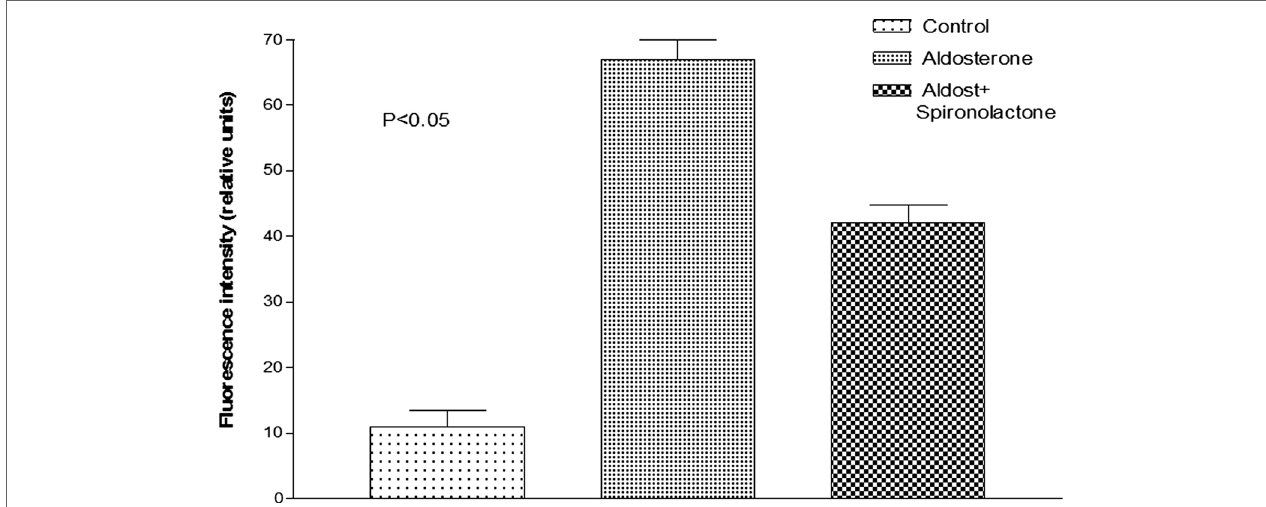
FigUre 6 | influence of aldosterone on oxidative stress . Each bar is the average from 23 ventricular myocytes (4 animals). Vertical line at each bar SEM ( P <